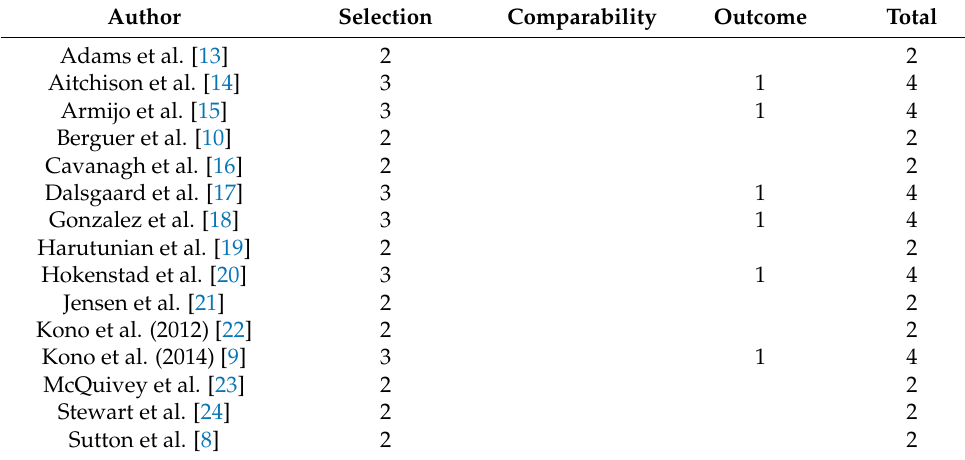
Table 1. Quality of evidence in the selected papers for the systematic review according to the Newcastle–Ottawa